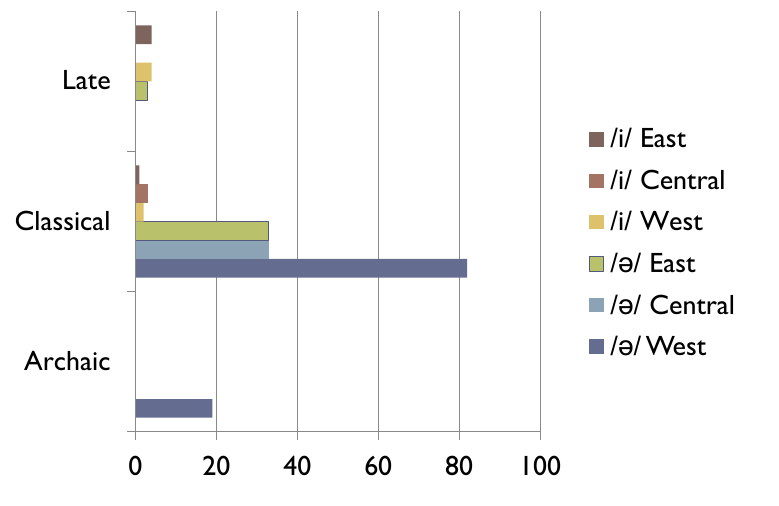
Figure 4: Attestations of other (selected) examples showing raised and non-raised variants according to regional distribution (absolute